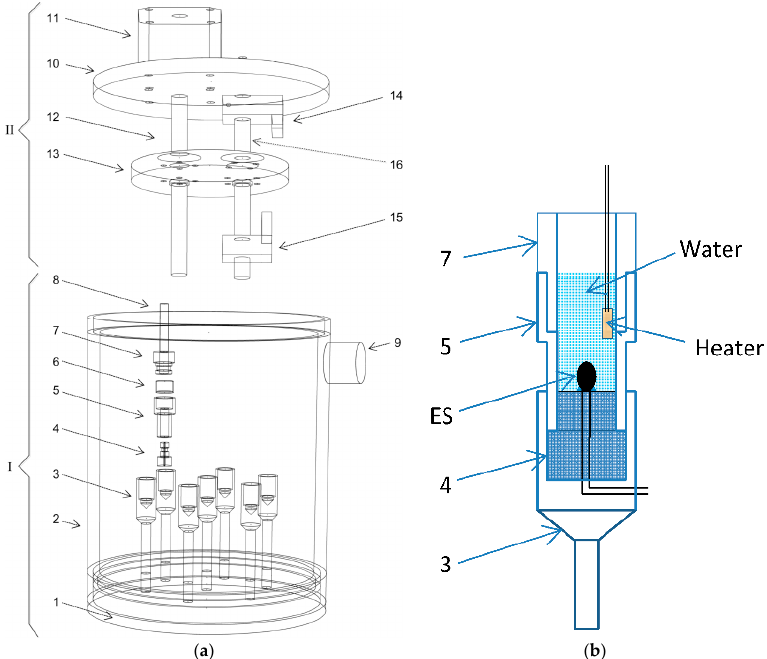
Figure 1. ( a ) The three-dimensional exploded view of the measurement unit of the proposed multichannel calorimetric simultaneous assay platform; only one of seven detachable reaction vessels is displayed; ( b ) Detailed arrangement of sensor plugs and chip heater in detachable reaction vessel during electrical